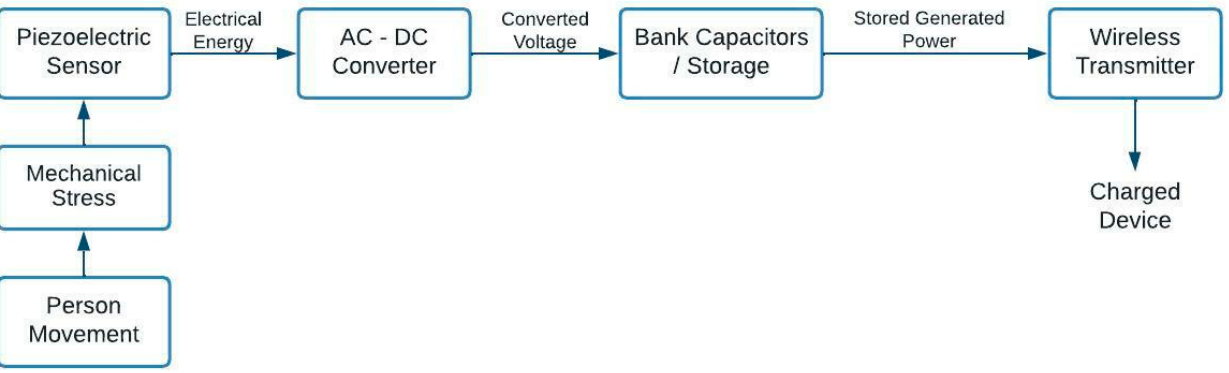
Figure 8. Hardware Components Communication Flowchart.